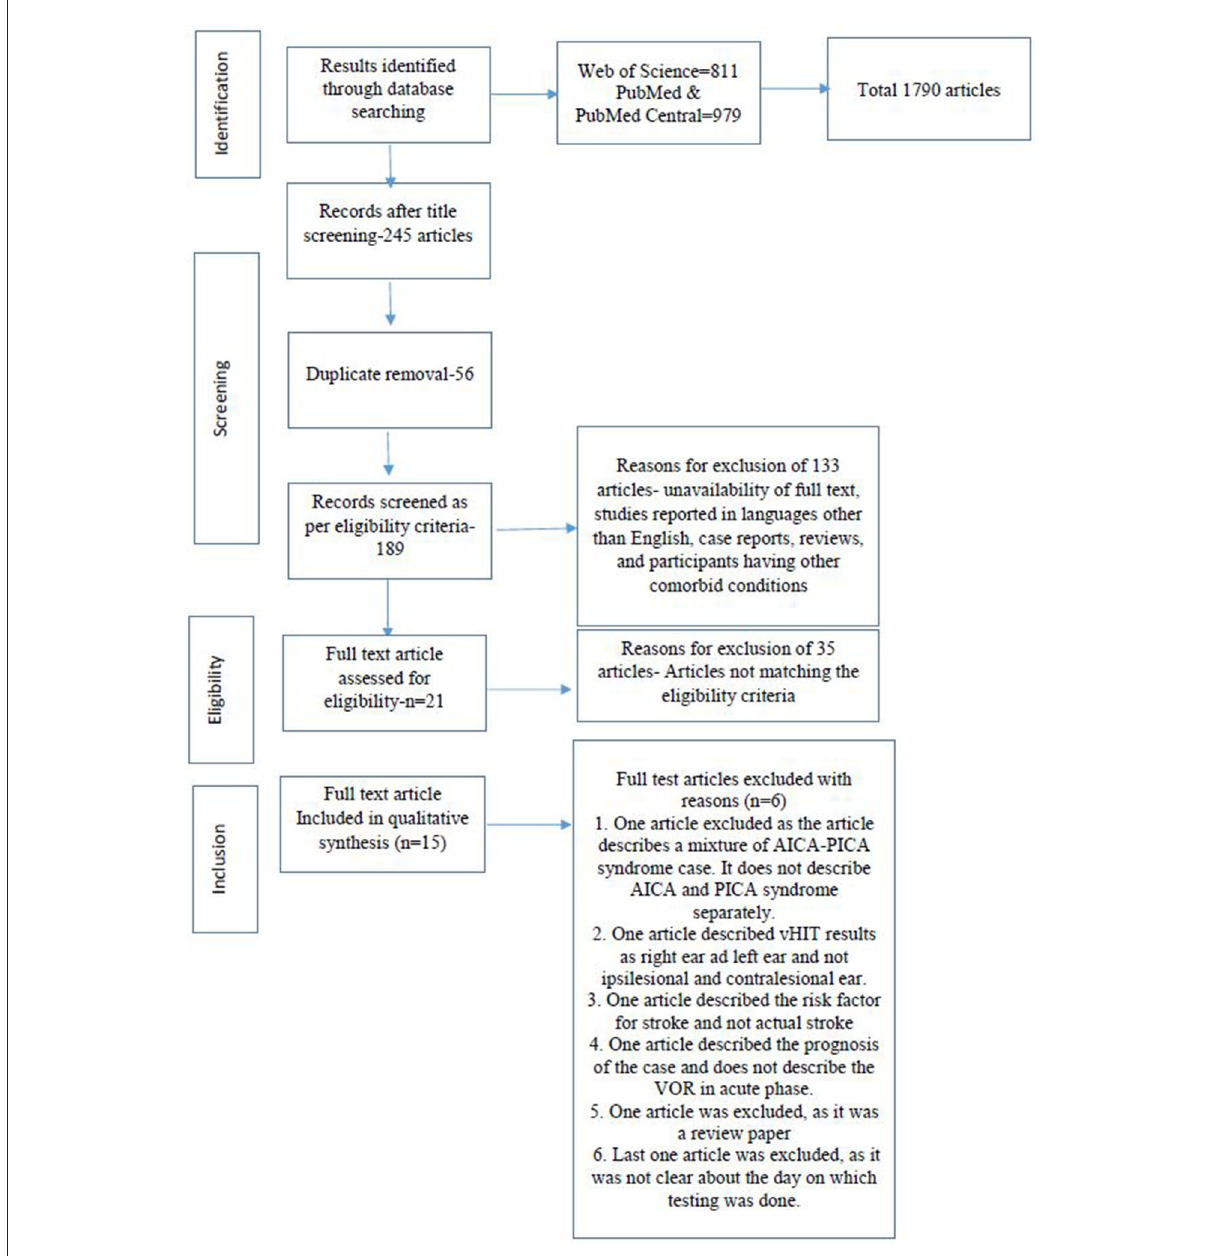
FIGURE1 PRISMA chart for systematic reviews and meta-analysis.